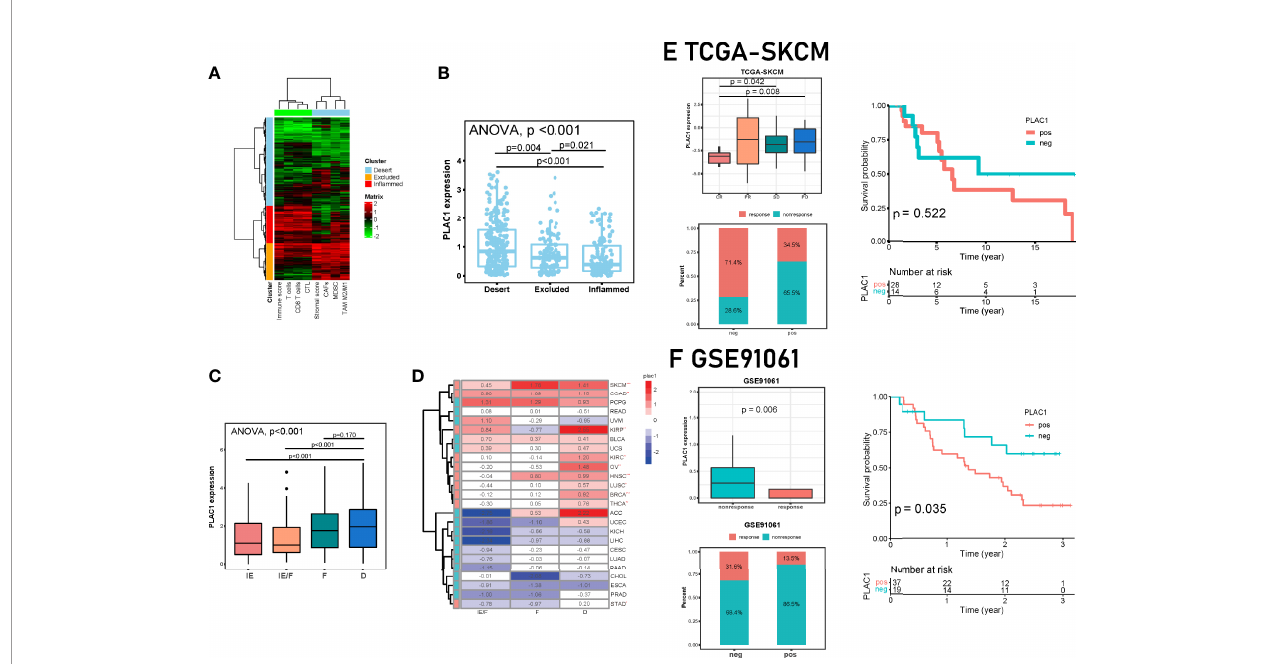
FIGURE 5 | Correlations among plac1, the immune phenotype, and the clinical response to immunotherapy across cancers. (A, B) The Cancer Genome Atlas-head and neck squamous cell carcinoma samples were divided into three immune phenotypes based on eight gene signatures. A clustering heat map is shown in (A) . The differences in Plac1 expression levels in the three immune phenotypes are shown in (B) . Here we used one-way ANOVA test and p < 0.001; dessert vs . excluded: p = 0.004, dessert vs . in fl amed: p < 0.001; excluded vs . in fl amed: p = 0.021. (C) Differences in the expression level of plac1 in different microenvironment (TME) phenotypes in HNSC. Here we used one-way ANOVA test and p < 0.001; immune-enriched/non fi brotic (IE) vs . immune-depleted (D): p < 0.001; immune-enriched/ fi brotic(IE/F) vs . D: p < 0.001; fi brotic(F) vs . D: p = 0.170. (D) Differences in the expression level of plac1 in different TME phenotypes in pan-cancer. Here we used t -test and compared between IE/F and D groups. SKCM, skin cutaneous melanoma; COAD, colon adenocarcinoma; PCPG, pheochromocytoma and paraganglioma; READ, rectum adenocarcinoma; UVM, uveal melanoma; KIRP, kidney renal papillary cell carcinoma; BLCA, bladder urothelial carcinoma; UCS, uterine carcinosarcoma; KIRC, kidney renal clear cell carcinoma; OV, ovarian serous cystadenocarcinoma; LUSC, lung squamous cell carcinoma; BRCA, breast invasive carcinoma; THCA, thyroid carcinoma; ACC, adrenocortical carcinoma; UCEC, uterine corpus endometrial carcinoma; KICH, kidney chromophobe; LIHC, liver hepatocellular carcinoma; CESC, cervical